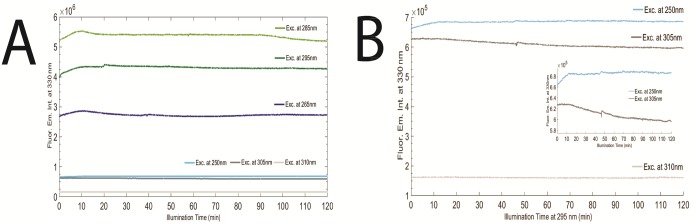

A) LYZ 2 hours excitation from 250 nm until 310 nm, at 20°C. Fluorescence emission wavelength was fixed at 330 nm, while excitation wavelengths were selected as following: at 250 nm (light blue), at 265 nm (dark blue), at 285 nm (light green), at 295 nm (dark green), at 305 nm (dark grey) and at 310 nm (light grey). B) Closer look at LYZ 2hours excitation at 250 nm, 305 nm and 310 nm, at 20°C. For all excitation wavelengths, fluorescence emission wavelength was fixed at 330 nm and slit fixed at 0.5 mm (1.0 μW).